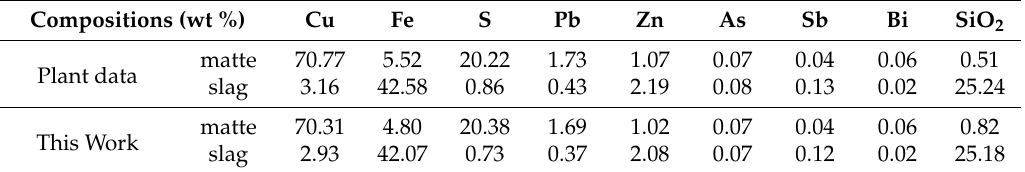
Table 6. Comparison of calculated data with actual plant data of matte and slag compositions in the SKS process.